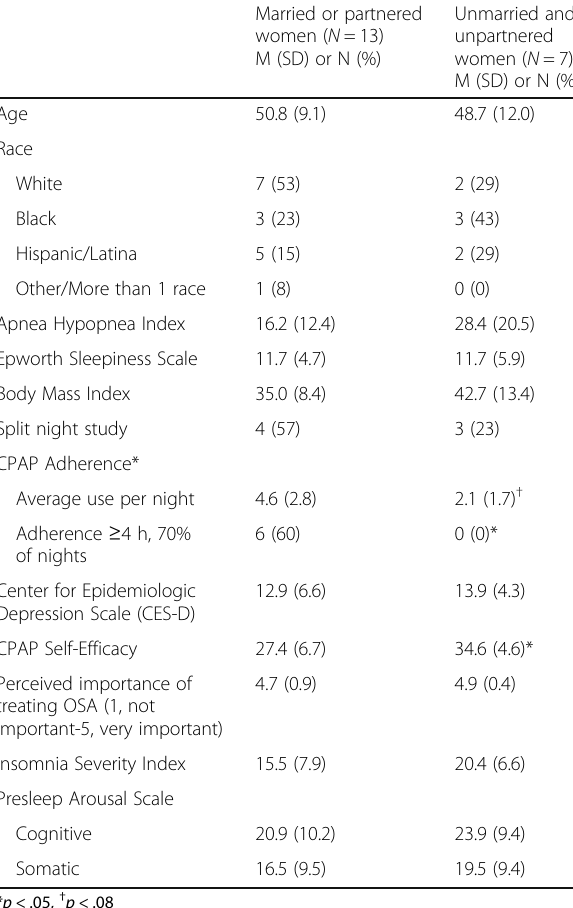
versus unmarried/unpartnered participants Married or partnered women ( N =